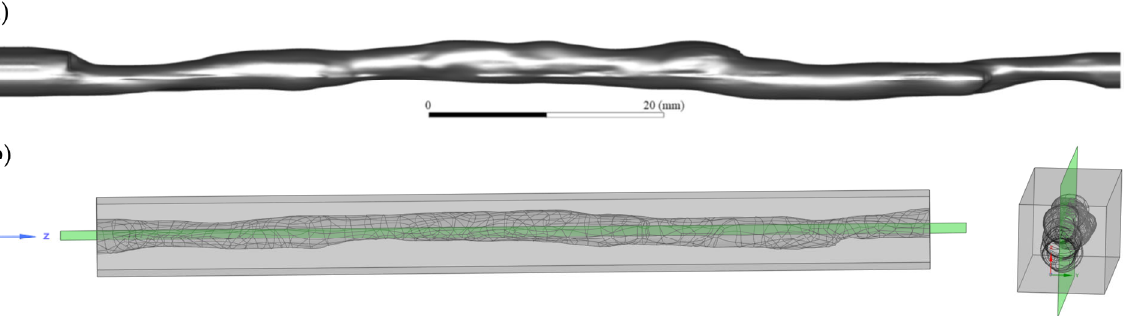
Figure 1. Geometry of the coronary artery: ( a ) side view and ( b ) model prepared for 3D printing with the location of the laser plane relative to the geometry. the location of the laser plane relative to the